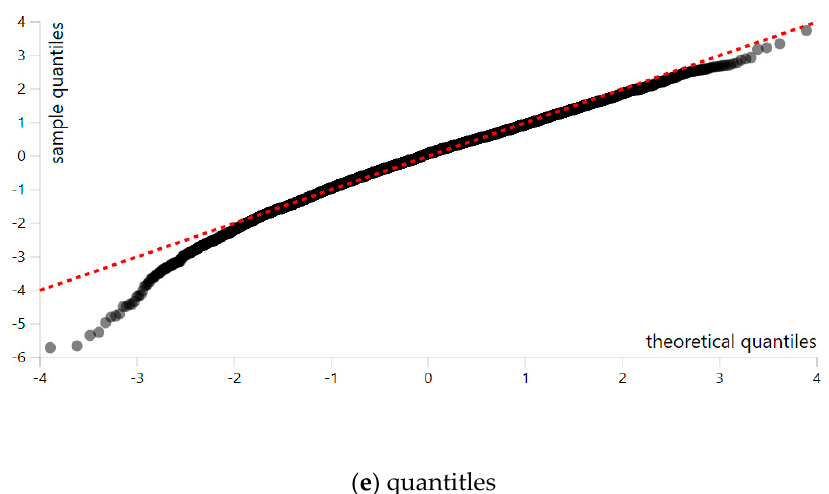
Figure A1. Working memory; ( a ): outcome, ( b ): Right hippocampus, ( c ): Left hippocampus, ( d ): Residuals of the model, ( e ):